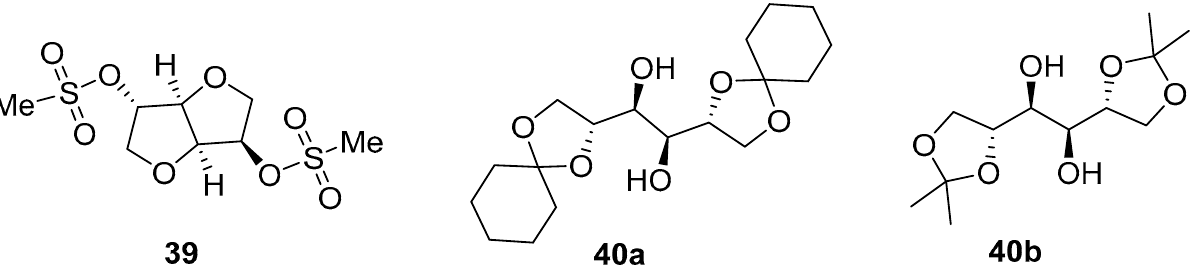
Figure 28. Structures of isosorbide derivative 39 and D-mannitol derivatives 40a–b [75]. Raju et al. reported three xylitol based organogelators 41a – c as shown in Figure 29 [76]. They were found to form gels in a variety of organic solvents and crude oils. Compound 41a was the best gelator in the series for crude oil gelation, forming gels with the highest mechanical strength. Using the gelator in powdered form did not lead to the formation of gels in biphasic solutions of crude oil and water; however, adding a solution of the gelator in toluene did. Gelation for various refinery fractions and crude oil occurred within two minutes. After removal of the solidified oil layer from the biphasic solutions, vacuum distillation was carried out to recover the oils and the gelators. The recovered gelators were reused and underwent five cycles with minimal loss in